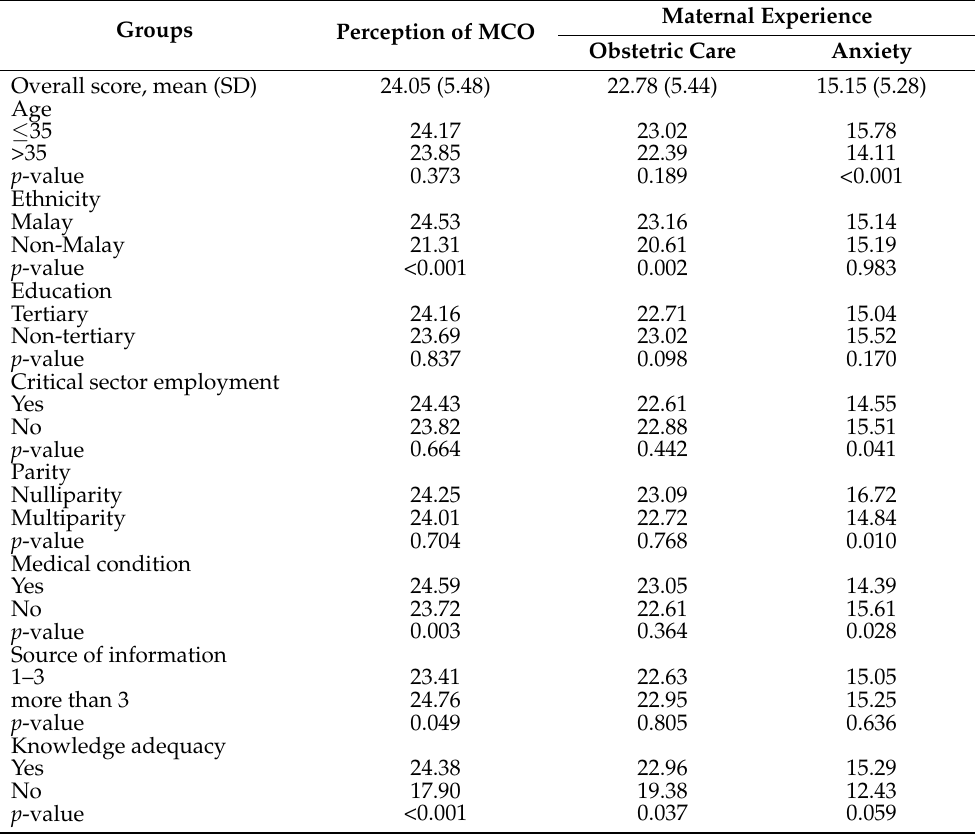
Table 5. Mean scores comparison between different socio-demographic and clinical factors.